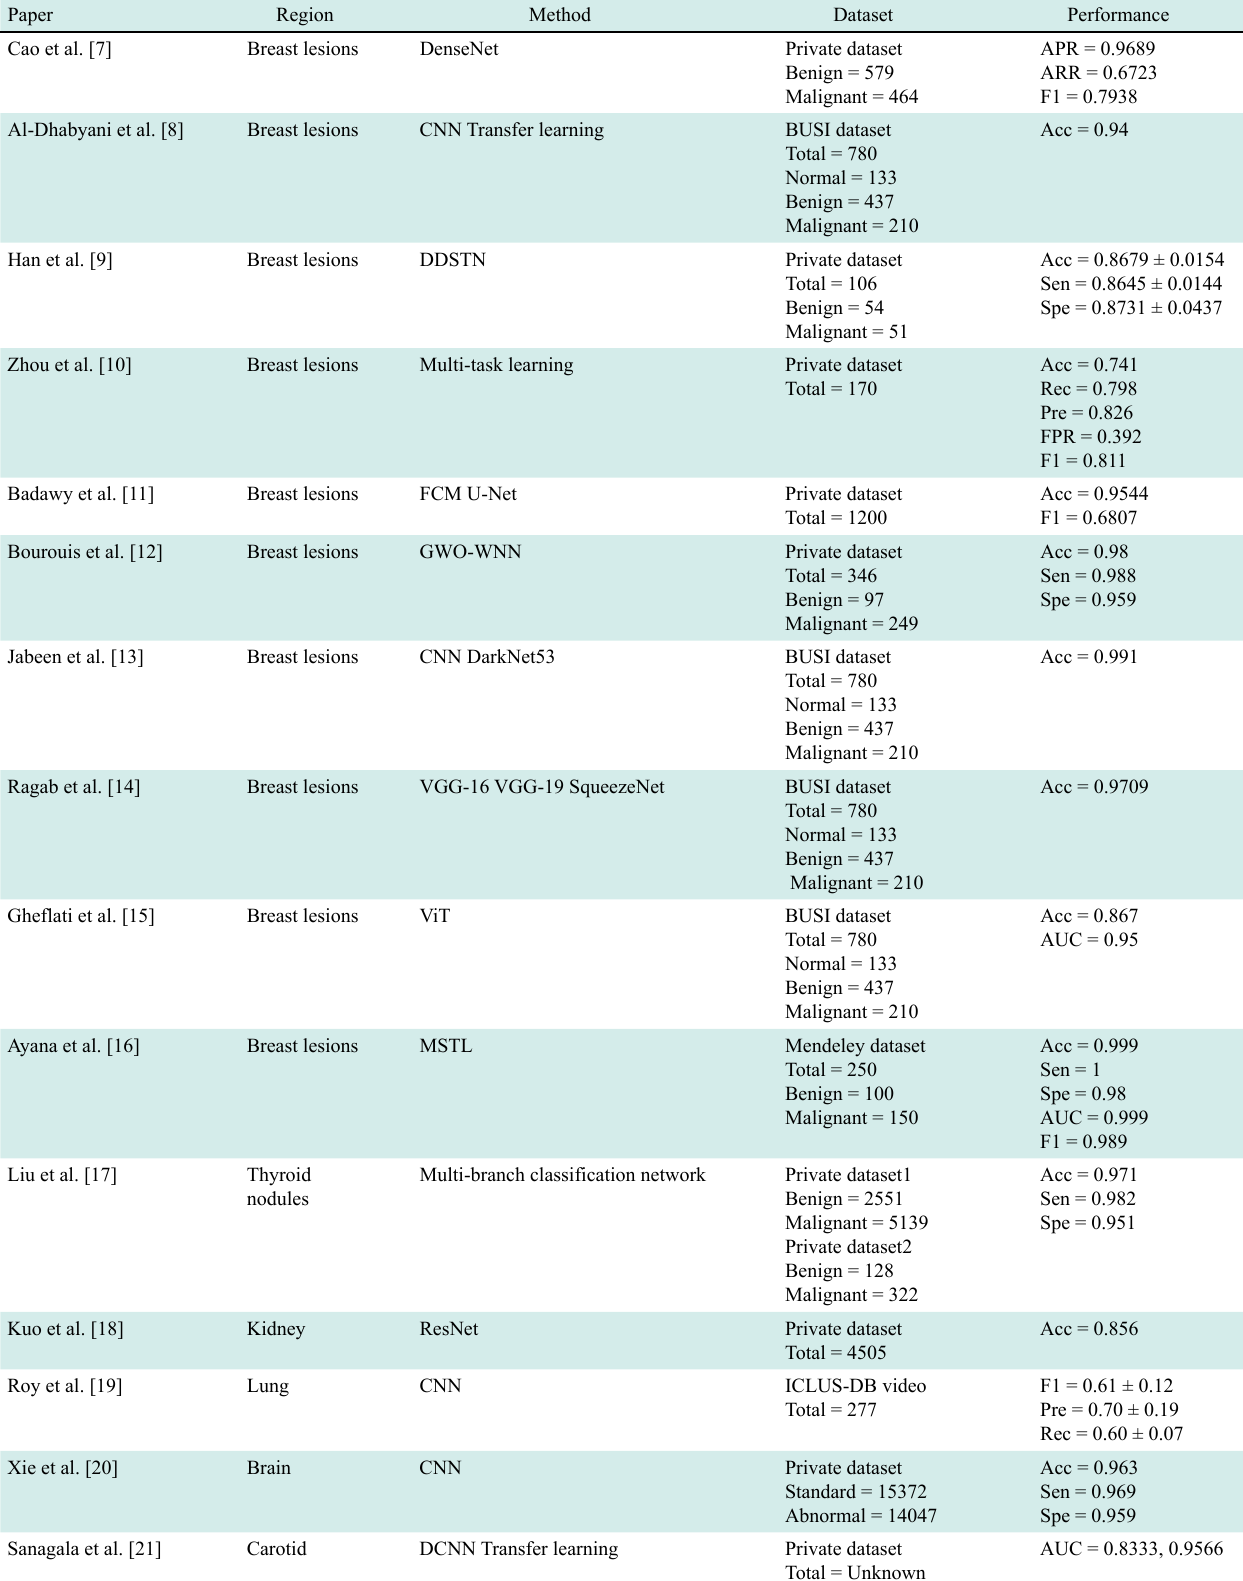
Table 1 Summary the areas of interest, methods, data sets and performance of major researches on AI in the field of medical ultrasound classification in recent